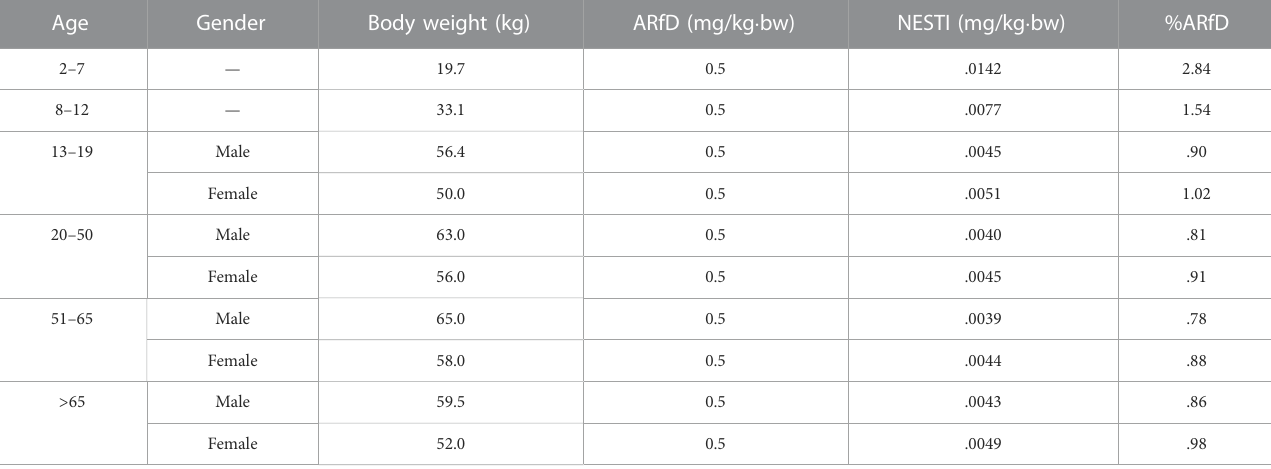
TABLE 7 The short-term dietary exposure risk assessment of fl uopyram in